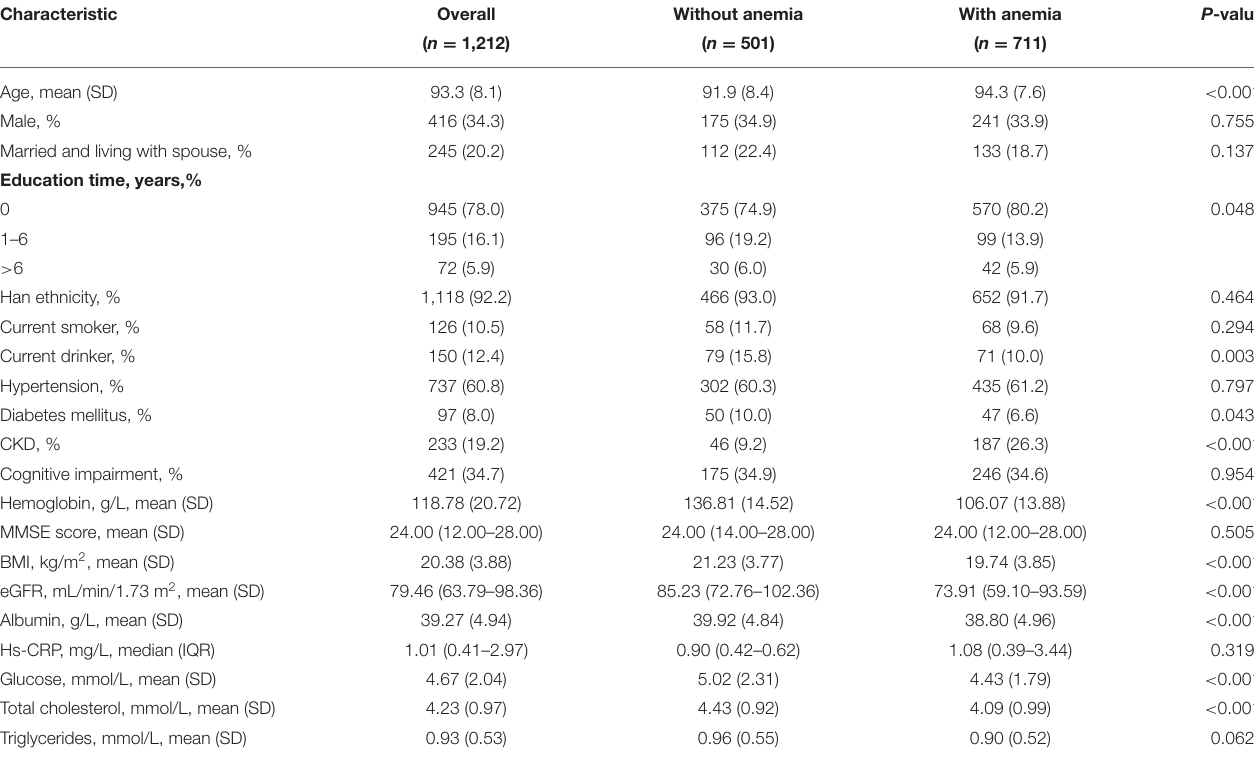
TABLE 1 | General characteristics of the 1,212 participants with and without